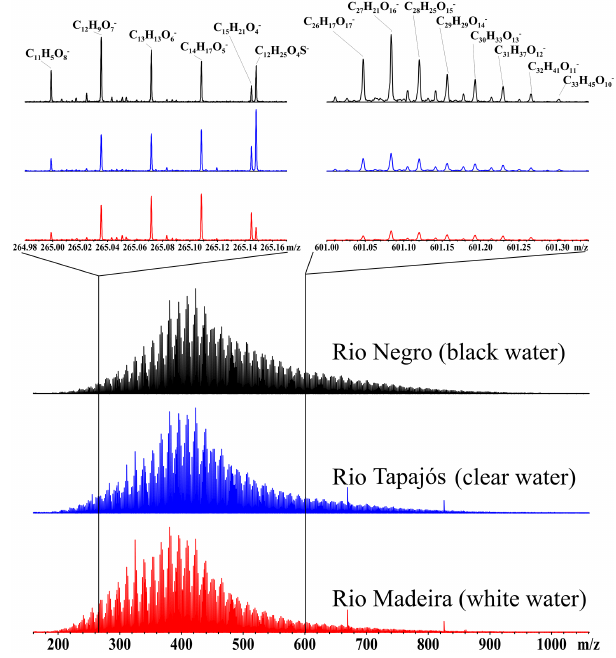
Figure 1. Ultrahigh-resolution FT-ICR mass spectra of SPE-DOM isolated from the main stem of the Rio Negro, Rio Madeira and Rio Tapajós, Amazon, Brazil and the stacked relative abundances of all ions at nominal mass 265 and 601 for all three river systems (note the differences in peak intensity for individual m/z peaks).